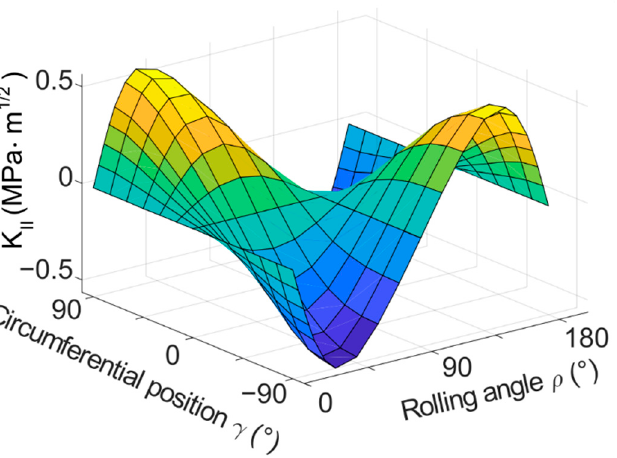
Figure 7. 3D plot of K II as a function of both, the circumferential position on the crack front γ and the rolling orientation of the crack ρ , crack length a = 1.25 mm.